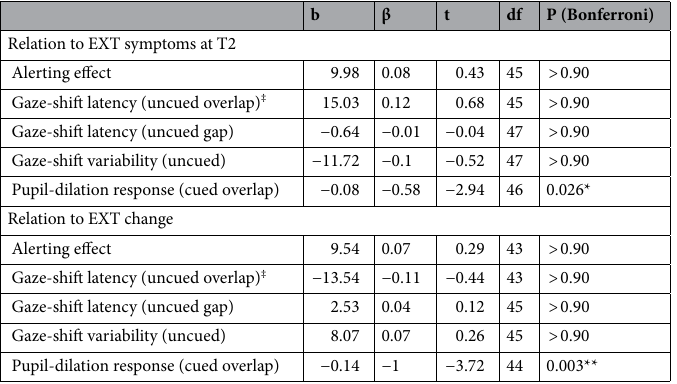
Table 3. Relations between eye-movement measures, externalizing symptoms (EXT) at T2 and change in EXT symptoms from T1 to T2. EXT externalizing symptoms. * p < 0.05 (Bonferroni-corrected). ‡ 1 outlier observation removed. Unstandardized b coefficients indicate the predicted change in ms (gaze shift latency) or pupil size (mm).